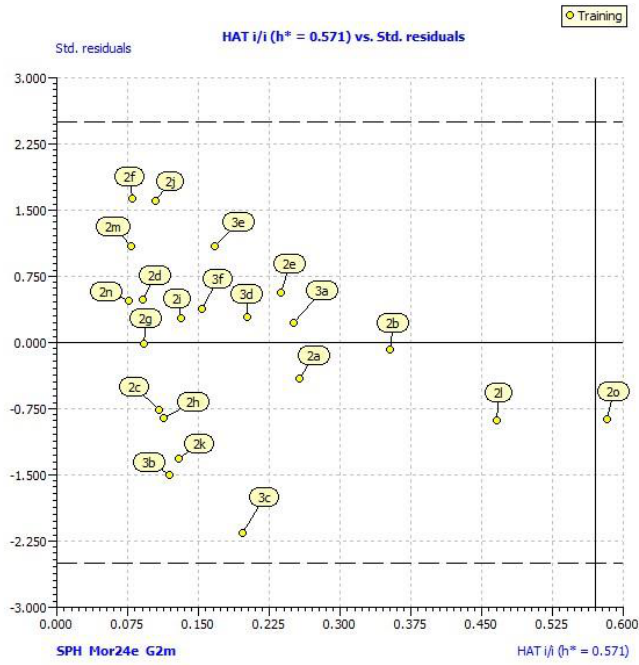
Figure 1. Williams plot of the applicability domain of the quantitative structure-activity relationship (QSAR) model for antioxidant activity calculated by model (1).